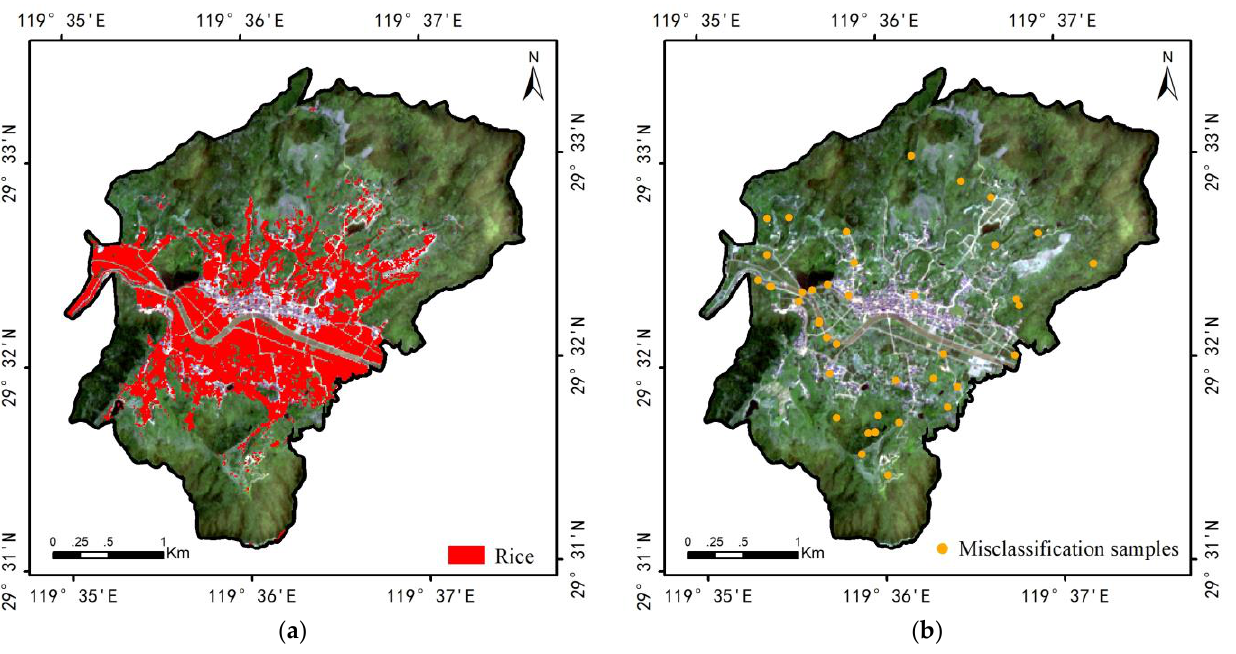
Figure 7. Map of the optimal distribution of mountain rice and the distribution of “ misclassification verification ” samples. ( a ) Optimal distribution map of mountain rice, ( b ) distribution map of misclassification verification samples.